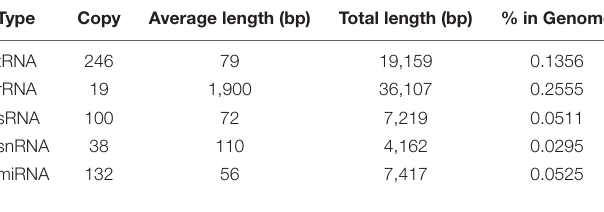
TABLE 4 | Statistics of different types of ncRNA in the C. oleophila genome.